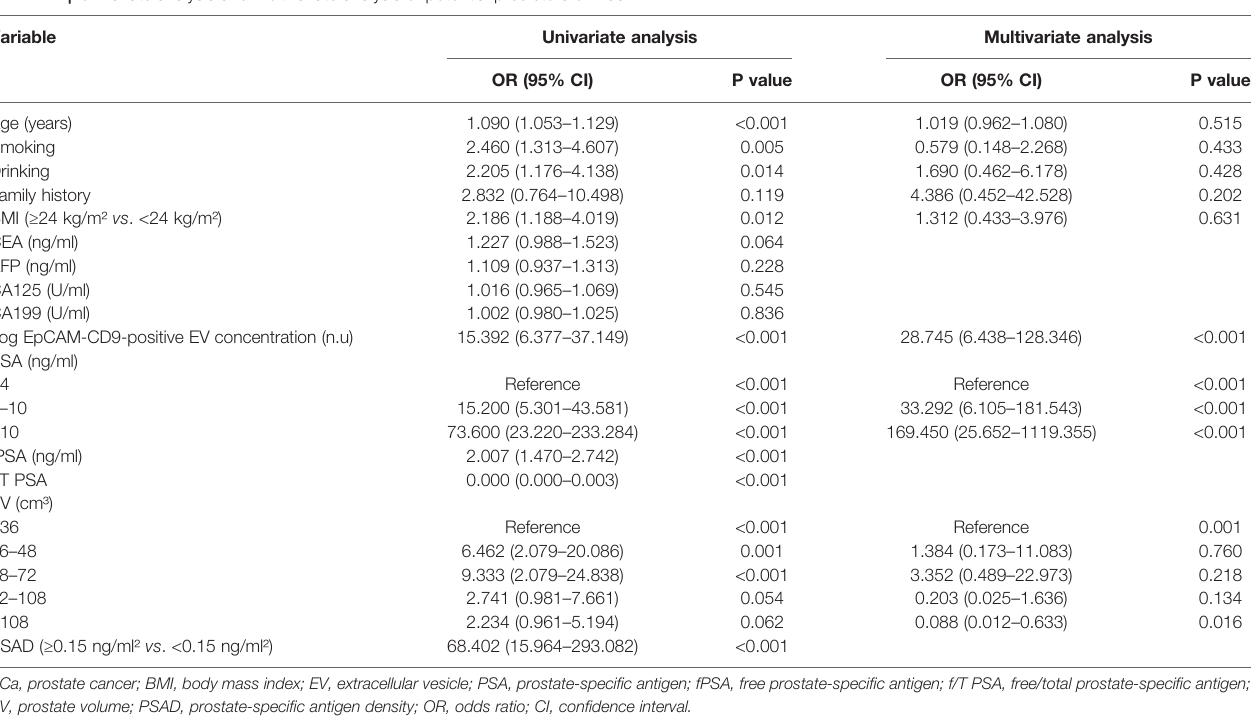
TABLE 2 | Univariate analysis and multivariate analysis of potential predictors of PCa.